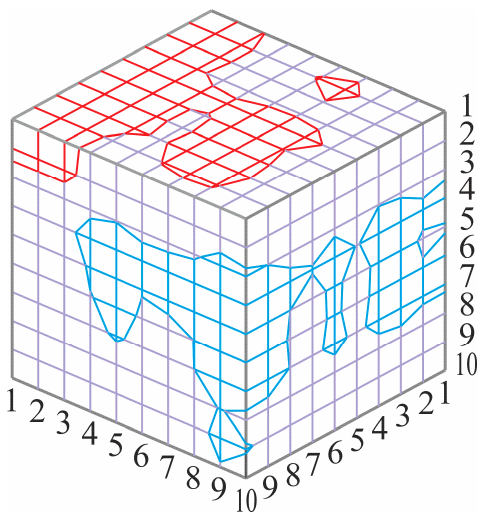
Figure 3. Example of a three-dimensional random field representing Young’s modulus; the numbers on respective axes denote node ordinal numeration. The assessed displacements δ i (i = 1, . . . , 200) of a highly correlated random field RF ( d = 0.01 m − 1 ) are shown in Figure 4, along with the convergence diagrams for both mean value µ δ and standard deviation σ δ of model response. The figure detects two positive RF RF vertical axes—standard deviation is presented on a positive upward axis, while displace- ments refer to a positive downward axis, the latter reflecting the settlement direction. This assumption is valid in subsequent similar